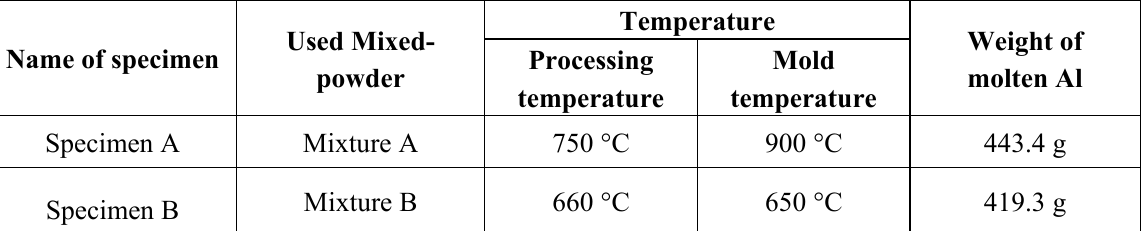
Table 4. Casting conditions for Al/TiO